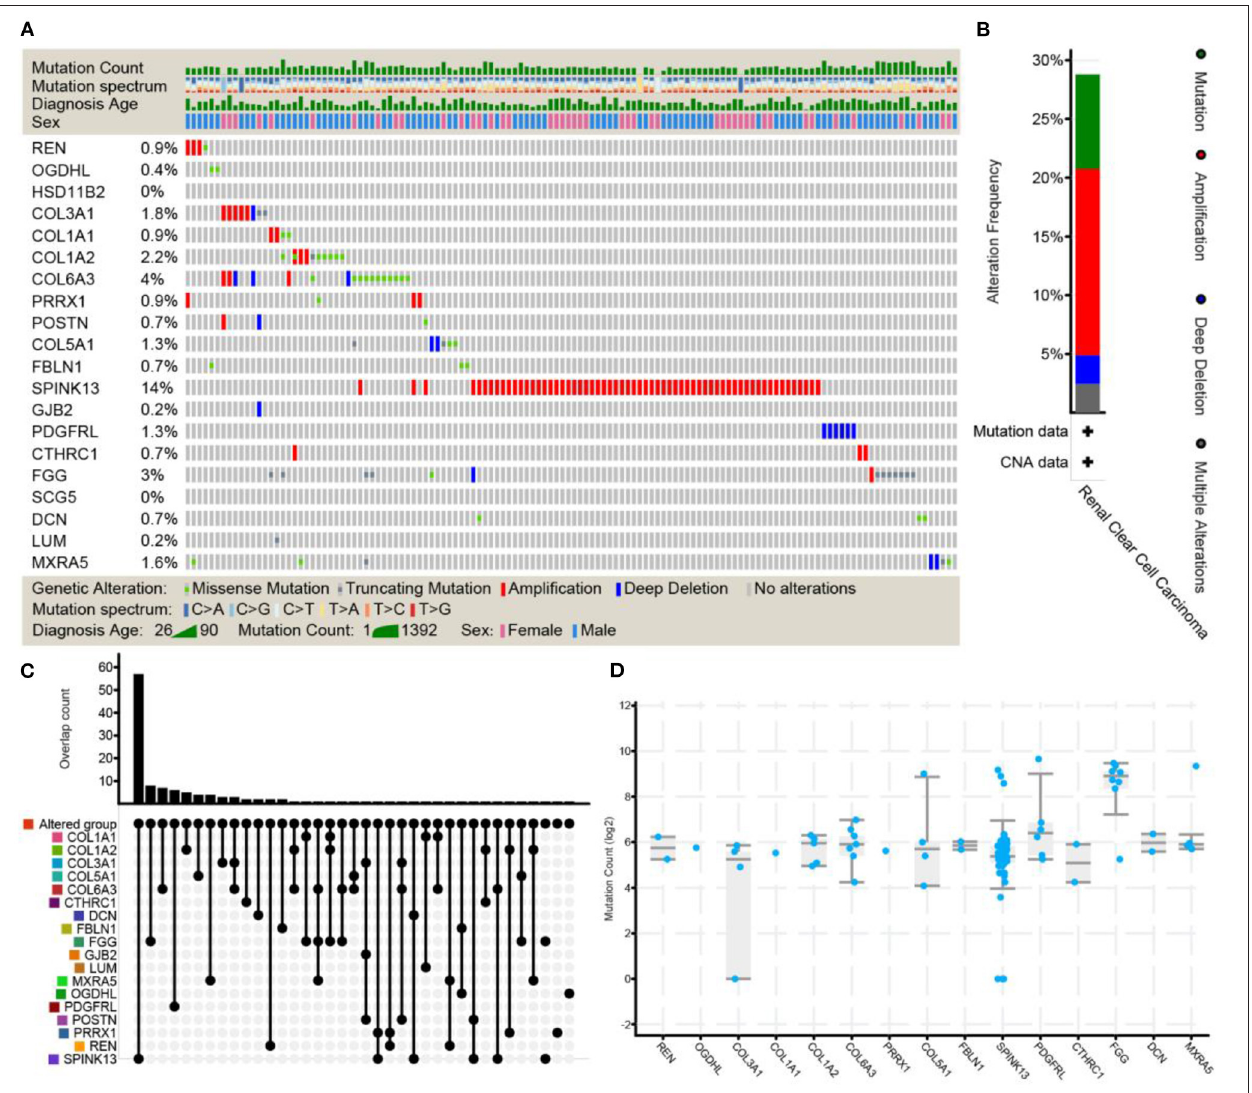
FIGURE 7 | The frequency of genetic alterations (including mutations, amplifications, deletions, and fusions associated with clinical parameters) of shared DEGs was evaluated through ccRCC studies using cBioPortal. Stacked plots show mutational burden (histogram, top), mutations in shared DEGs (tile plot, middle), and mutational marks (bottom) (A) . Overall description and cancer type summary of the selected sample (B) . The histogram combined with the dotted-line graph shows the overlap of samples (patients) (C) . Box plots display shared DEG mutation counts based on the Kruskal–Wallis test ( p = 0.0140) (D) . HSD11B2, POSTN, GJB2, SCG5, and LUM completely overlapped with other selected groups and were excluded from the analyses in other